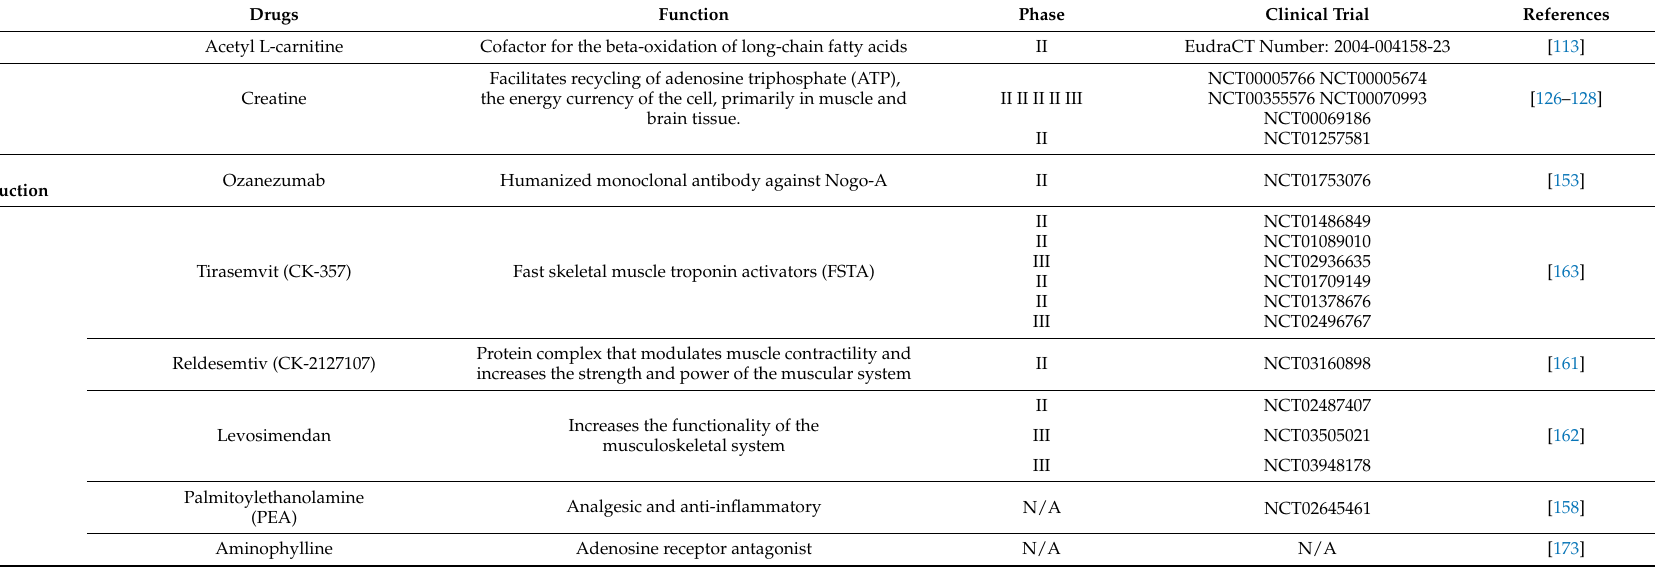
Table 3. Clinical pharmacological